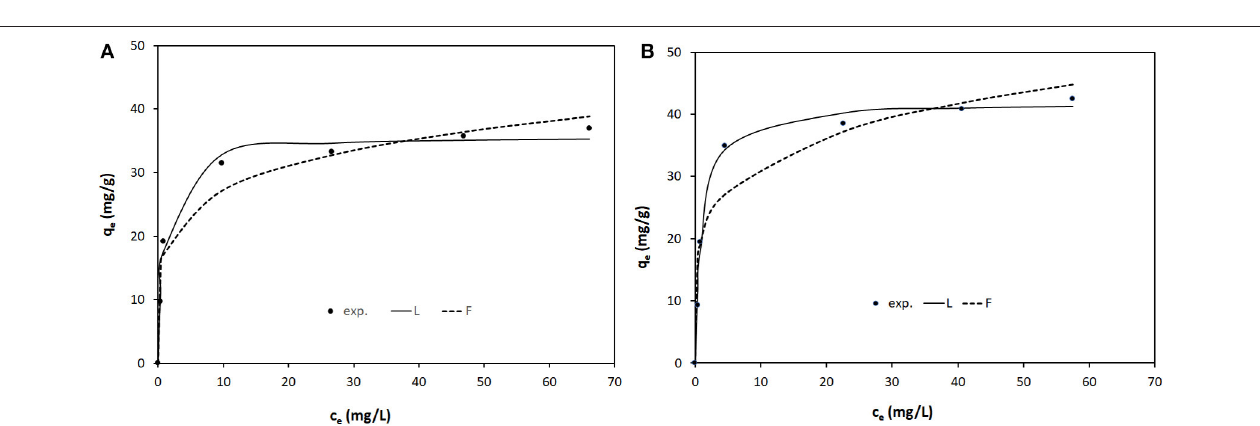
Frontiers in Chemistry |